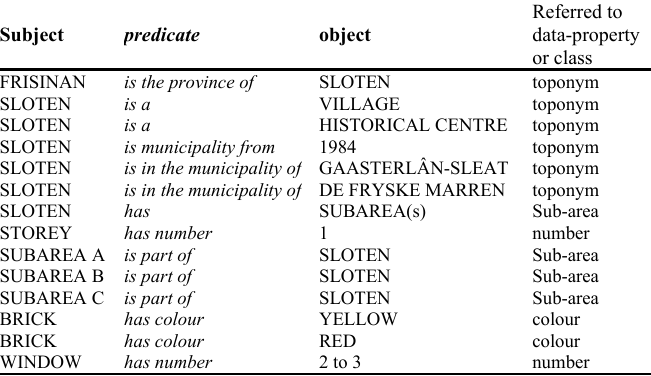
Table 5. Some instances (from general to specific) added during ontology